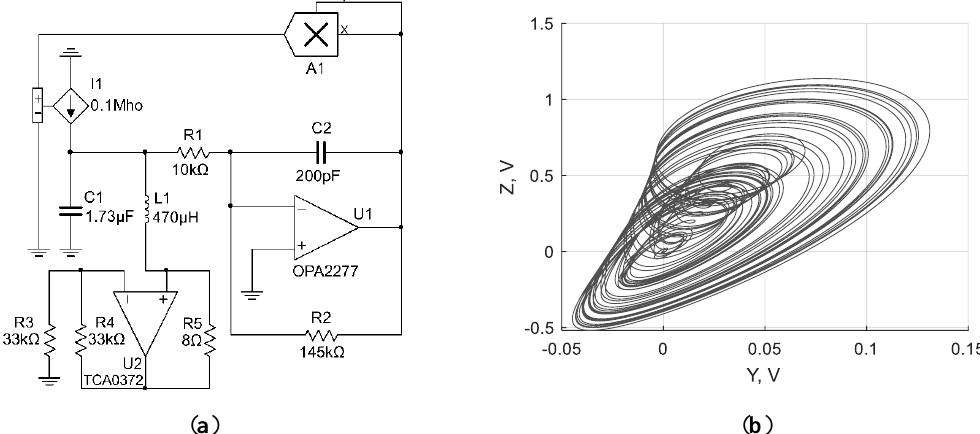
Figure 2. Chaotic circuit based on the Sprott Case N system with inductive element ( a ); corresponding attractor of the circuit ( b ).